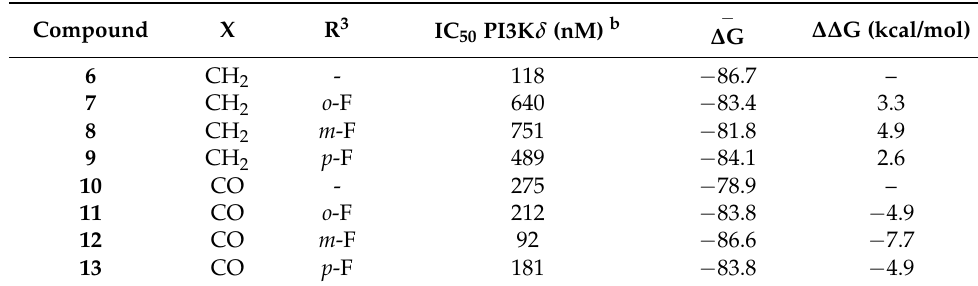
Table 4. Influence of the fluorine atom(s) on PI3K δ inhibition and the respective ∆ G and ∆∆ G a scores for each